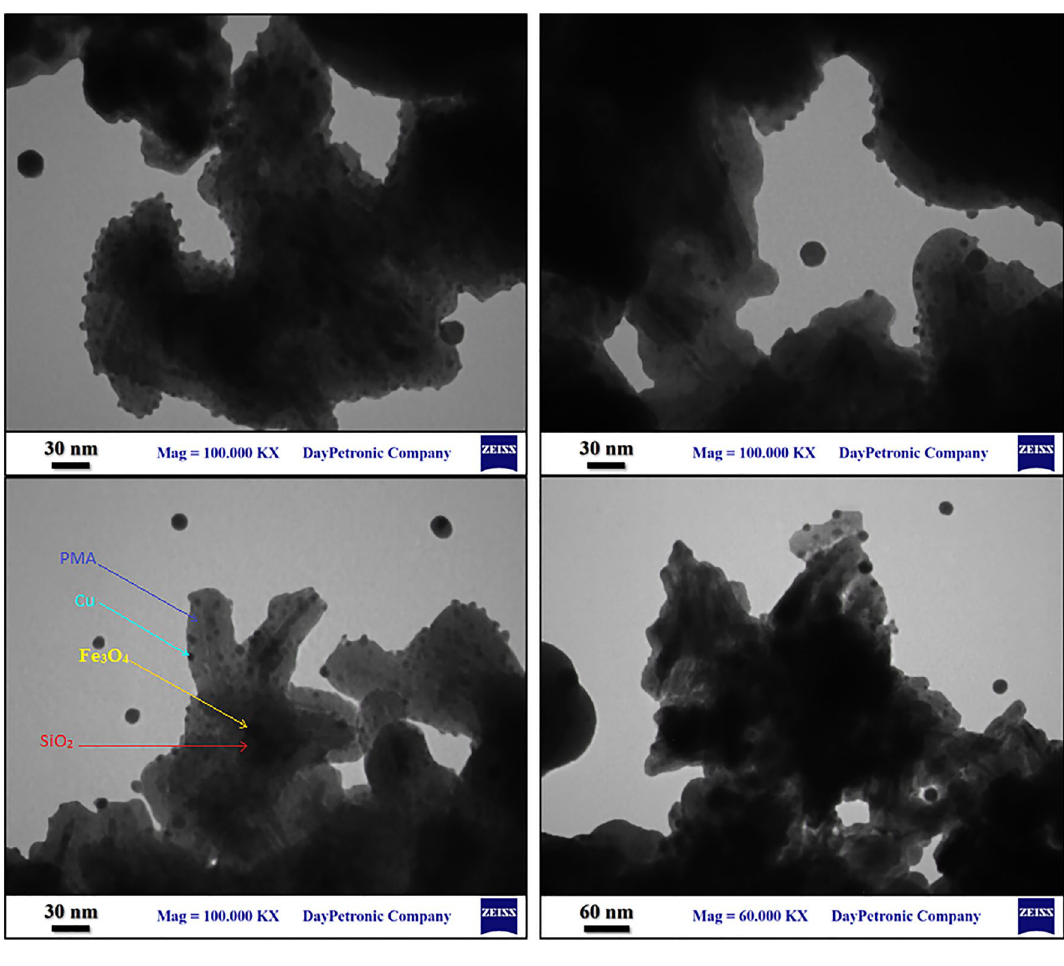
Figure 6. TEM images of Fe 3 O 4 @SiO 2